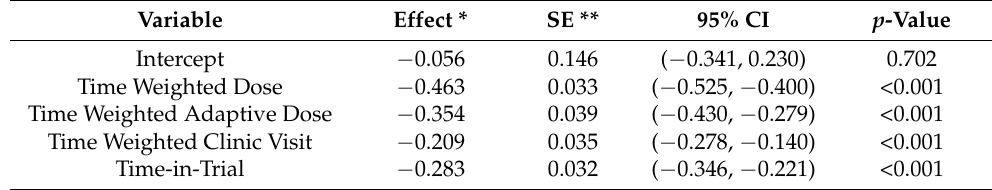
Table 2. Standardized Time Dependent Treatment Variable Effects on Short-term Lapse. Variable Effect * SE ** 95% CI p -Value Intercept − 0.056 Time Weighted Adaptive Dose −